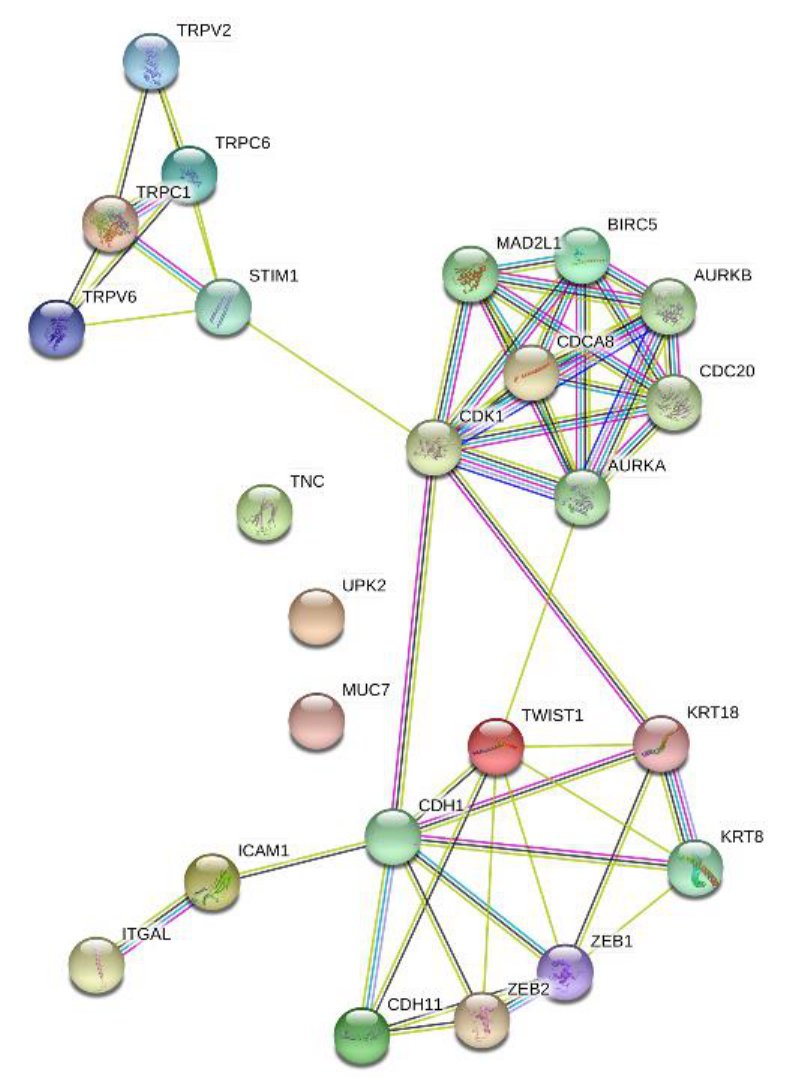
Figure 2. The selection of potential biomarkers. ( A ) The comparison of the mRNA expression level of the selected potential biomarker candidates between the normal and tumor tissues from thee TCGA-GTEx database using GEPIA. T = Tumor, N = normal bladder. ( B ) The protein–protein interaction network derived from STRING connects the selected markers (PPI enrichment, p value < 1.0 × 10 − 16 ).